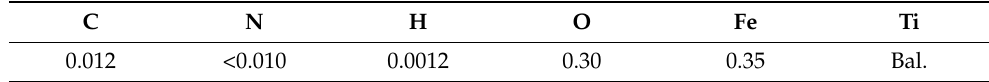
Table 1. Chemical composition of CP Ti Gr.4 ( ω /%).